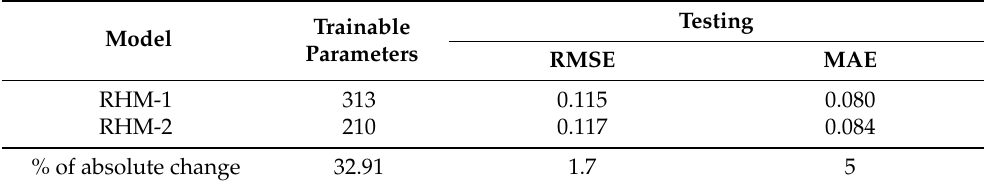
Table 11. Comparison between RNN models for HAM.